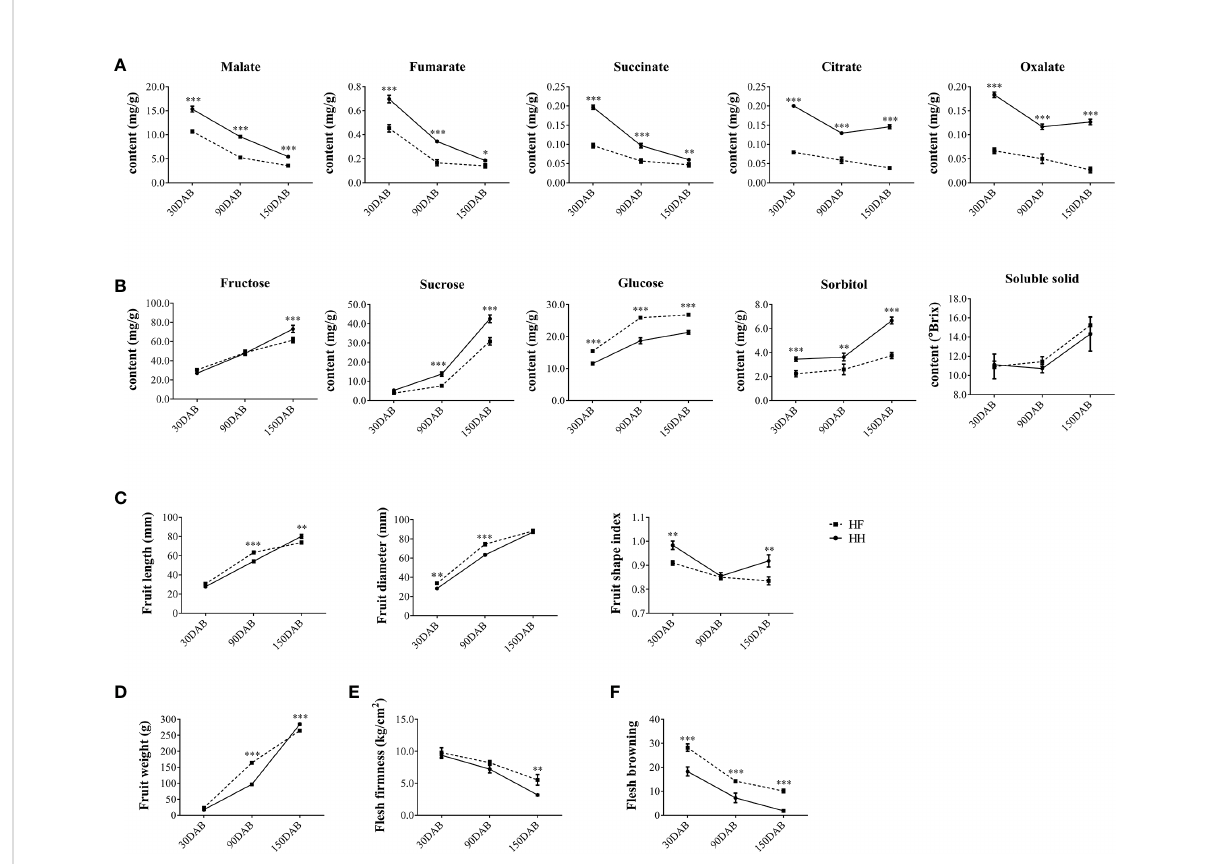
FIGURE 1 Fruit phenotype at different stages of ‘ HanFu ’ and ‘ Huahong ’ fruit development. (A) Contents organic acid in fruit of the two cultivars at three stage of development [30, 90, and 150 days after fl owering (DAB)]. (B) Contents of sugars, sorbitol, and soluble solids in fruits of the two cultivars at the three stages of development. (C) Physical measurements of fruit length, diameter, and fruit shape index of the two cultivars at the three developmental stages. (D – F) Phenotypes of fruit weight, fl esh fi rmness, and fl esh browning showing variation during development. The error bars represent the standard deviation (SD) among the replicates (n = 5). *, **, and *** indicate signi fi cant difference between the two cultivars at P < 0.05, 0.01, and 0.001, respectively, as determined using Student ’ s t